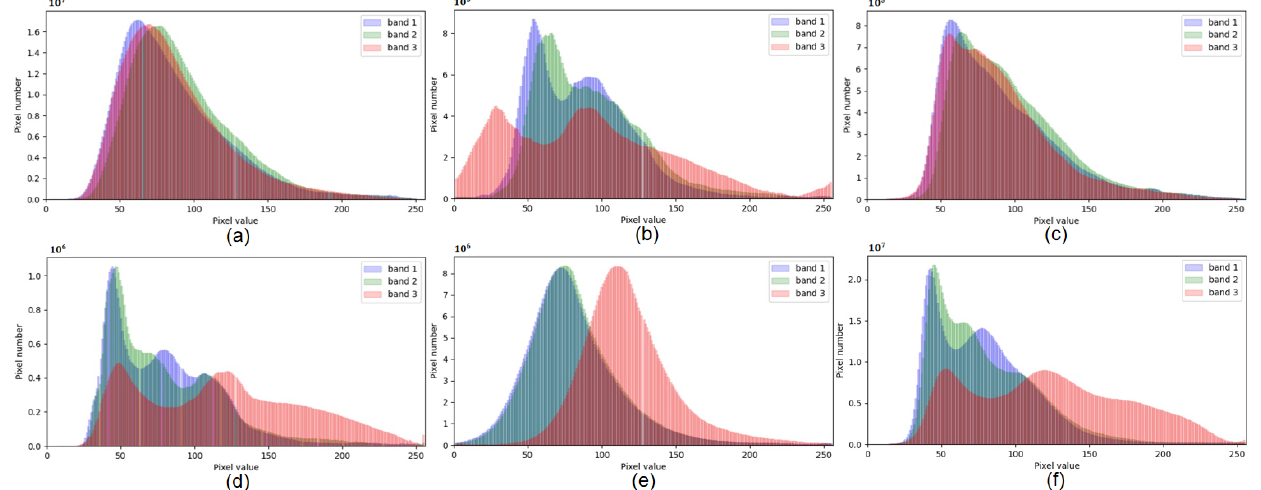
Figure 18. Color histograms of the ISPRS dataset. It is worth noting that Potsdam and Vaihingen have different kinds of bands. ( a ) Potsdam. ( b ) Pseudo Potsdam transformed by color matching. ( c ) Pseudo Potsdam transformed by BiFDANet. ( d ) Vaihingen. ( e ) Pseudo Vaihingen transformed by color matching. ( f ) Pseudo Vaihingen transformed by